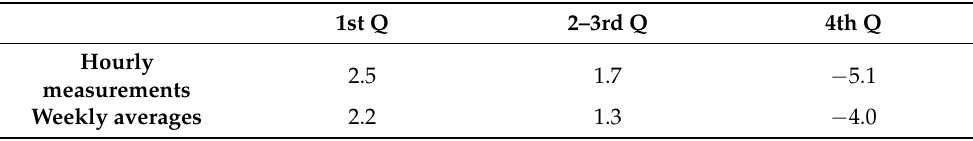
Table 2. Bias [ µ g/m 3 ] for estimations performed by RF model within the quartiles both for hourly measurements and weekly averages.